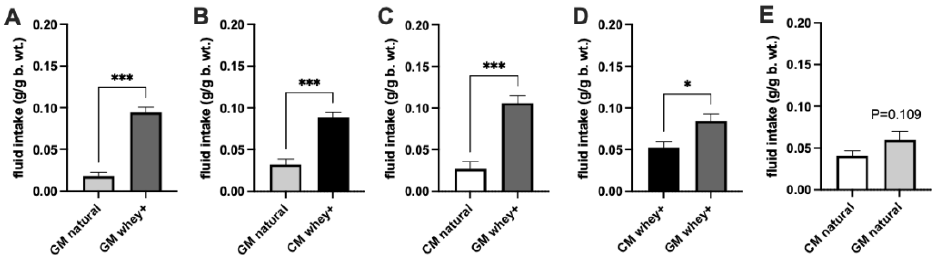
Figure 2. Consumption of simultaneously presented CM- and GM-based formulations with the natural control (20:80) and whey-adapted (60:40) whey:casein ratio. Non-deprived animals were given access to two bottles over a 2-h episodic exposure: ( A ) GM natural control and GM whey-adapted, ( B ) GM natural control and CM whey-adapted, ( C ) CM natural control and GM whey-adapted, ( D ) CM whey-adapted and GM whey-adapted and ( E ) CM natural control and GM natural control. * p ≤ 0.05; *** p ≤ 0.001.